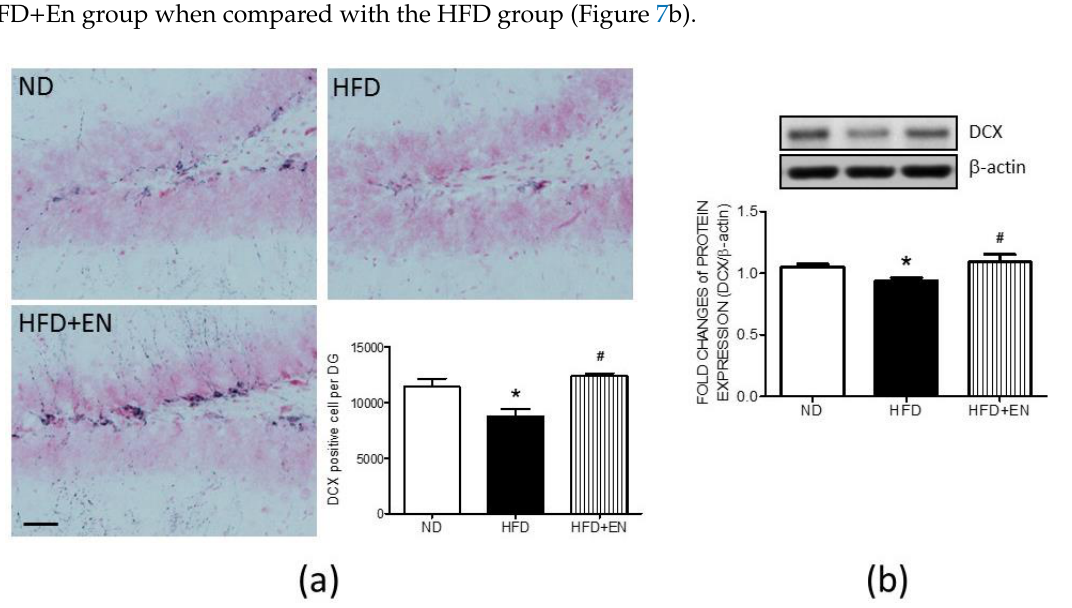
Figure 7. Enriched housing counteracted the suppression of doublecortin (DCX) in the maternal HFD group. ( a ) Representative images of DCX-positive cells and cell numbers in dentate gyrus, and ( b ) protein expression of DCX in the hippocampus of female offspring at 12 weeks old. Values were mean ± SEM, ND: n = 12; HFD: n = 12; HFD + En: n = 6. * p < 0.05 indicate significant differences from the ND group and # p < 0.05 indicate significant differences from the HFD group using a post-hoc Tukey’s multiple range test . ND: female offspring exposed to a maternal normal diet; HFD: female offspring exposed to a maternal high-fructose diet; enriched housing for 4 weeks (En). β -actin was used as the internal loading control. Scale bar: 50 μ m.